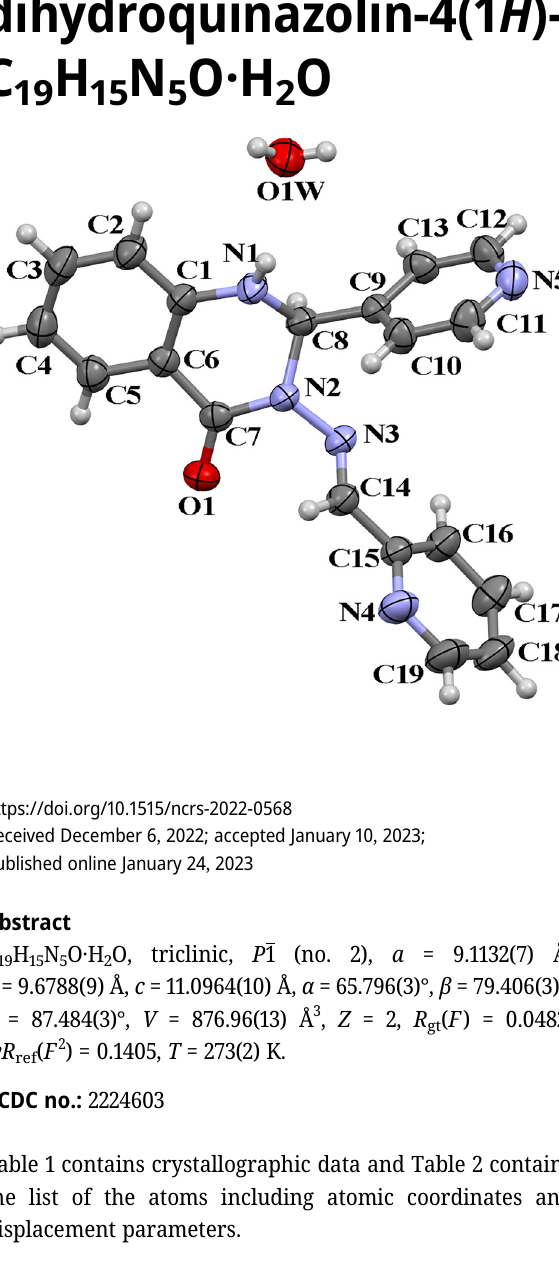
Table 1 contains crystallographic data and Table 2 contains the list of the atoms including atomic coordinates and